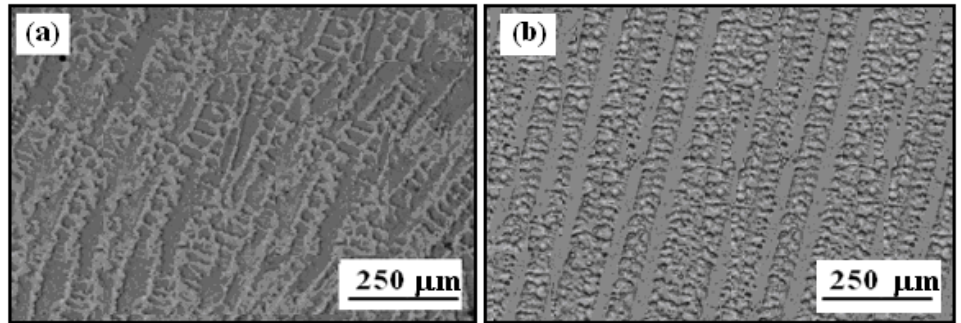
Figure 2. SEM images of the dendritic structure of Inconel 625 laser cladding coatings onto the S235JR substrate with the use of: ( a ) Wire or ( b ) Powder.